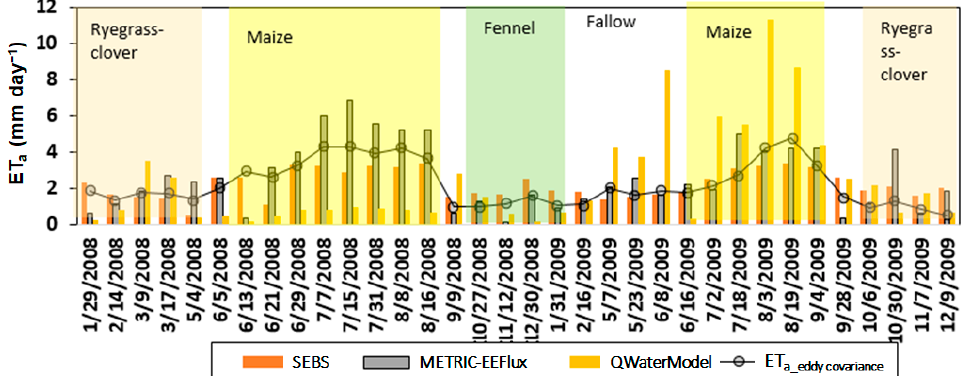
Figure 6. Comparison of model based ET a time-series (in bars) with measured ET a (in black dotted line) to present single-source models’ performance under the field scenario of IT_BCi Buffalo Farm in the Mediterranean climate. X -axis belongs to the image acquisition dates covering a two-year span of a rotational cropping system (2008–2009).